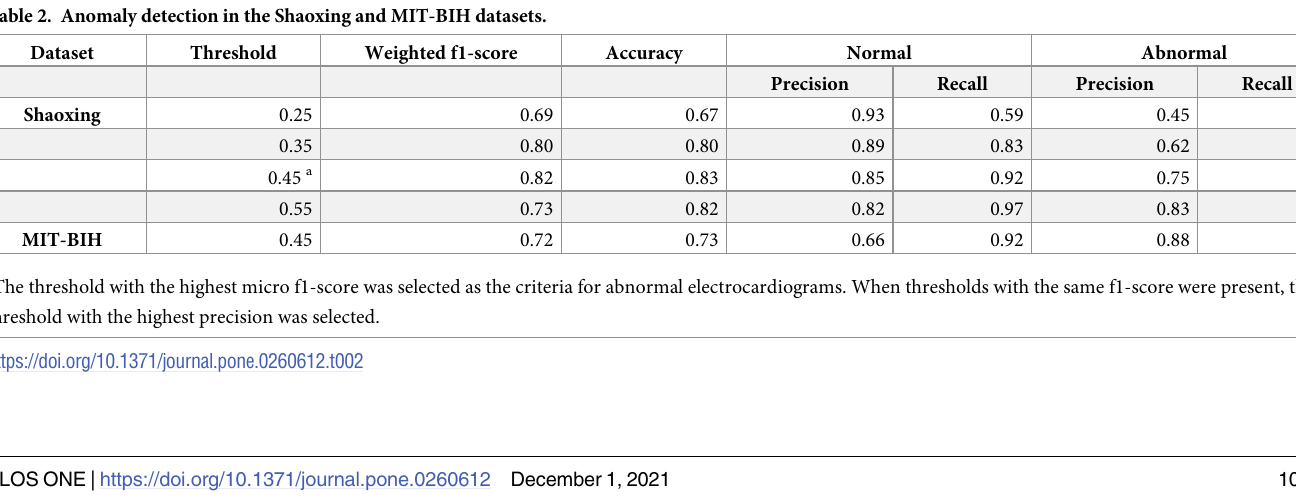
Table 2. Anomaly detection in the Shaoxing and MIT-BIH datasets. Dataset